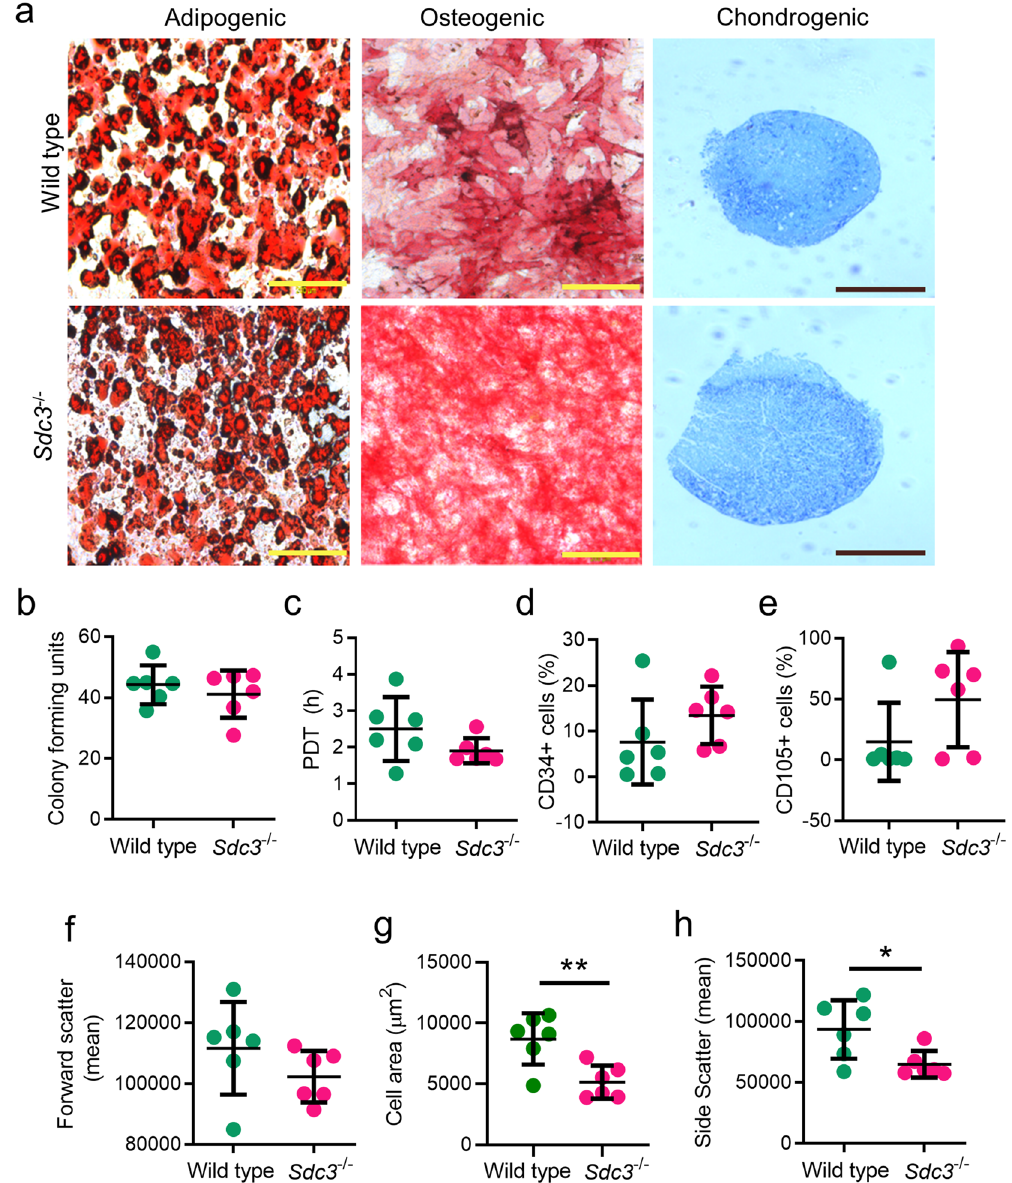
Figure 1. Characterisation of murine bone marrow MSCs. ( a ) Wild type and Sdc3 −/− MSCs show a similar trilineage differentiation potential in vitro. Yellow scale bar represents 200 µm; black scale bar represents 500 µm. The proliferative capability of MSCs were measured by ( b ) fibroblast colony-forming units and ( c ) average population doubling time (PDT). Dot plots displaying the percentage of cells expressing CD34 ( d ) or CD105 ( e ) as measured by flow cytometry. ( f ) The geometric mean of cell size was determined by forward scatter. ( g ) The morphometry, or cell spread, of cells were analysed using ImageJ. ( h ) The internal complexity of cells was measured by side scatter and the geometric means are shown. MSCs were isolated from wild type (n = 6) and Sdc3 −/− (n = 6) mice. Data presented as mean ± standard deviation unless otherwise stated; * p < 0.05; ** p <